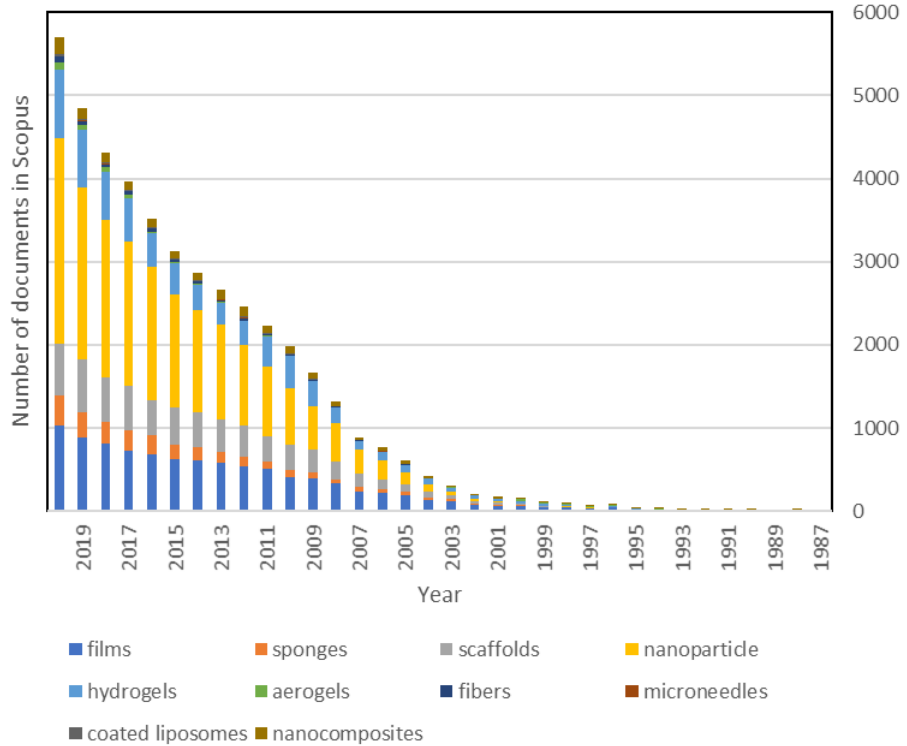
Figure 9. Publications about chitosan drug delivery in Scopus (1987 – 2020).